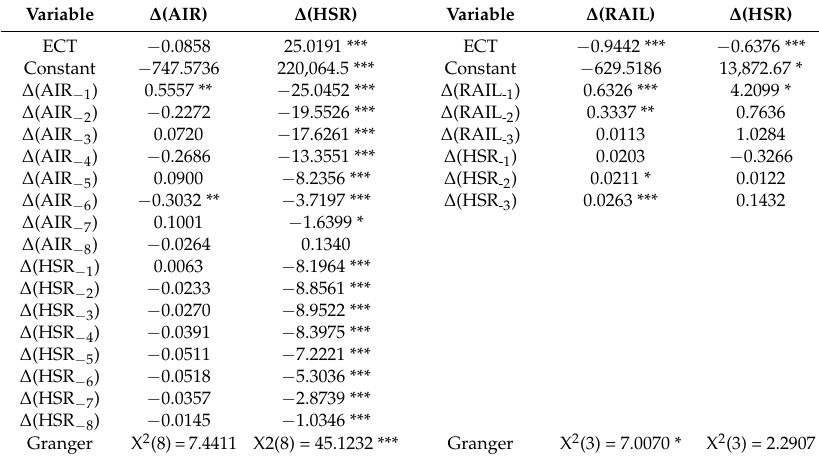
Table 6. Vector error correction estimates for short-run